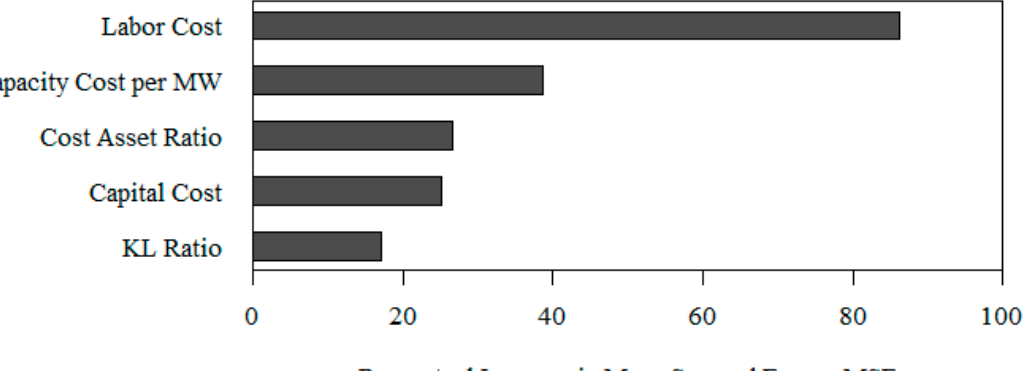
Figure 6. Relative importance of the cost structure variables for efficiency generation in thermal plants.